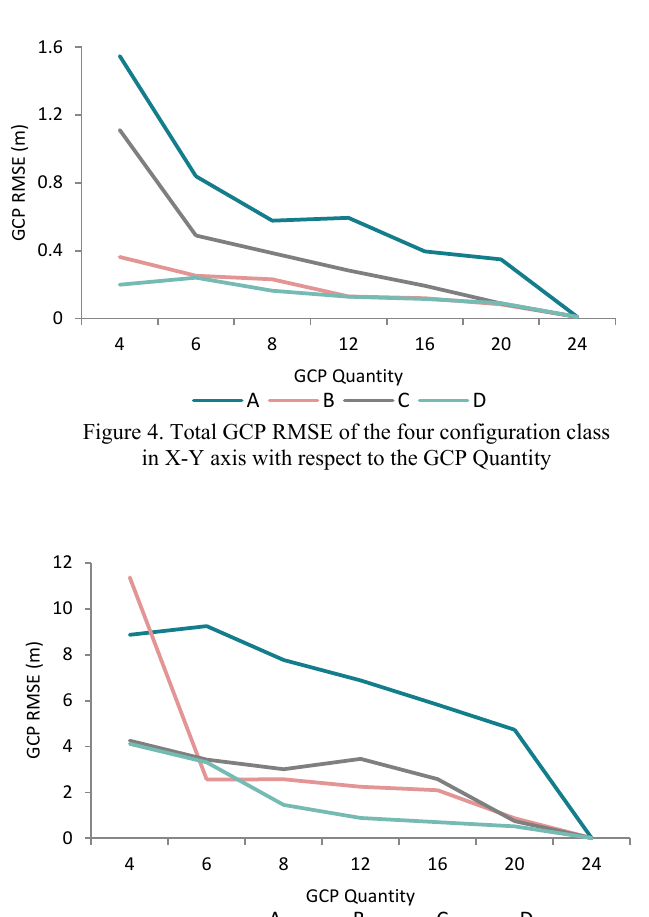
Figure 5. Total GCP RMSE of the four configuration